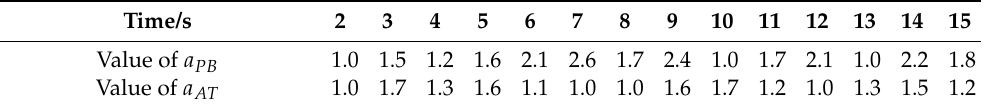
Table 7. Random sequence a PB and a AT . Time/s